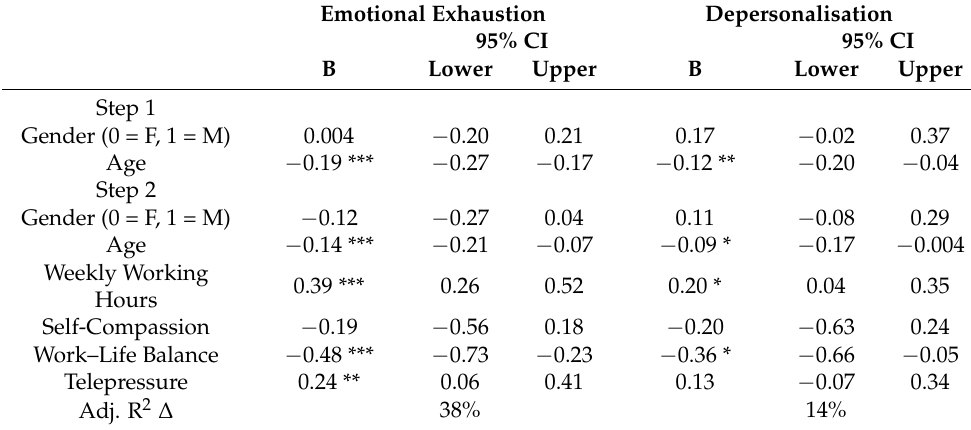
Table 3. Multiple regression: weekly working hours, self-compassion, work–life balance and telepres- sure to burnout among professional psychotherapists ( n =